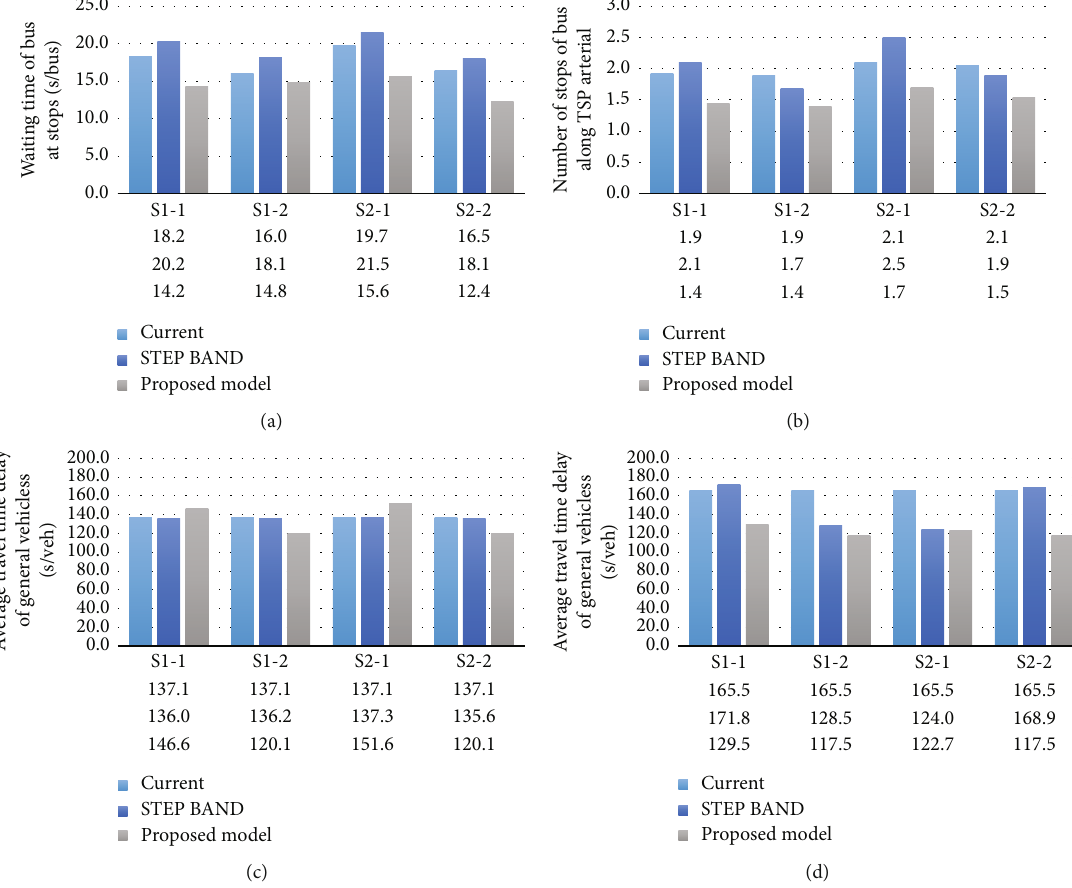
Figure 10: Performance comparison of three models in four scenarios: (a) average waiting times of bus at stops (s/bus); (b) number of